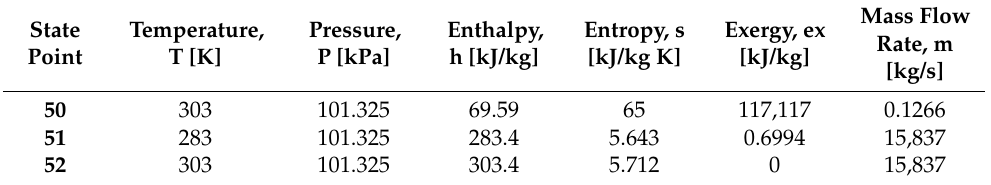
Table 5. State point values of Temperature, Pressure, Enthalpy, Entropy, Exergy and Mass flow rate